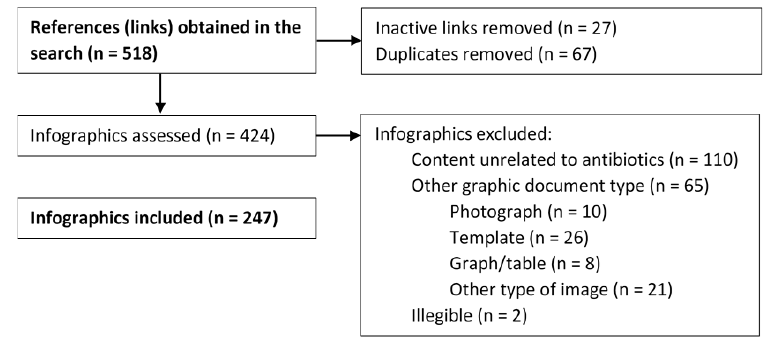
Figure 1. Infographic selection process.